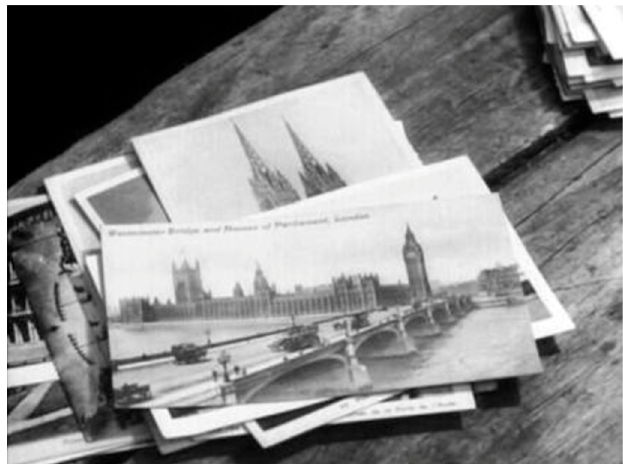
Figure 10. Still from Les Carabiniers , dir. Jean ‐ Luc Godard, 1963.